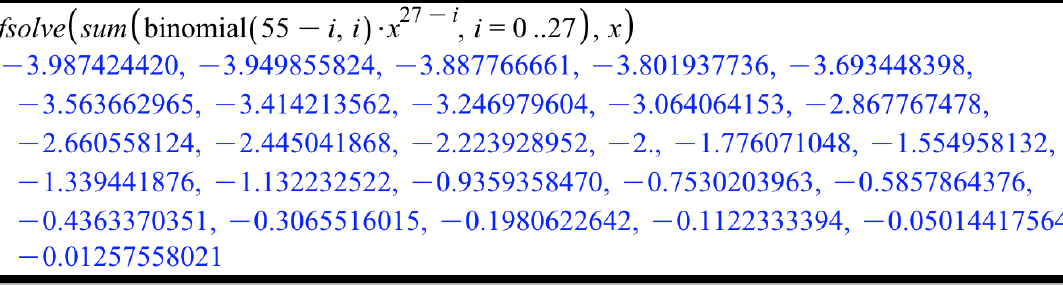
Figure 6. The roots of the equation P 54 ( x ) = 0. The ROA of the largest root of a third degree Fibonacci-like polynomial P 5 ( x ) is the 2 n − 1 position from the right on the ordered list of 7 · 2 n − 1 − 1 roots of the Fibonacci-like polynomial P 7 · 2 n − 2 ( x ) , n = 1, 2, 3, . . . .